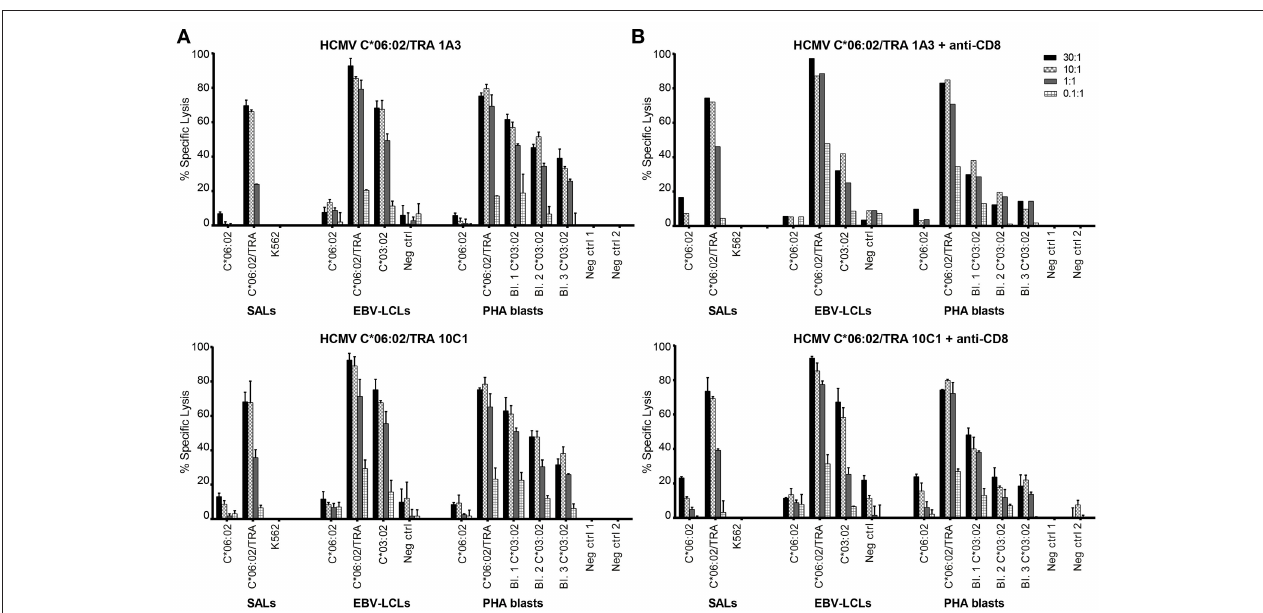
FIGURE 5 | HCMV C*06:02/TRA T cell lines and clones are cytotoxic against HLA-C*03:02. (A) Cytotoxicity of two HCMV C*06:02/TRA CD8 + T cell lines (1A3 shown) and one CD8 + T cell clone (10C1) was tested against 51 Cr-labeled EBV-LCLs and PHA blasts, obtained from three different donors, expressing the recognized allo-HLA-C*03:02 allele and the virus-specific restriction HLA allele loaded with viral peptide as a positive control. SALs expressing HLA-C*06:02 loaded with viral peptide were also included as a positive control. (B) The CD8 + T cell lines and clone were incubated with an anti-CD8 blocking antibody prior to co-culture with target cells and specific lysis was measured. Bars represent triplicate values with standard deviation of the mean.